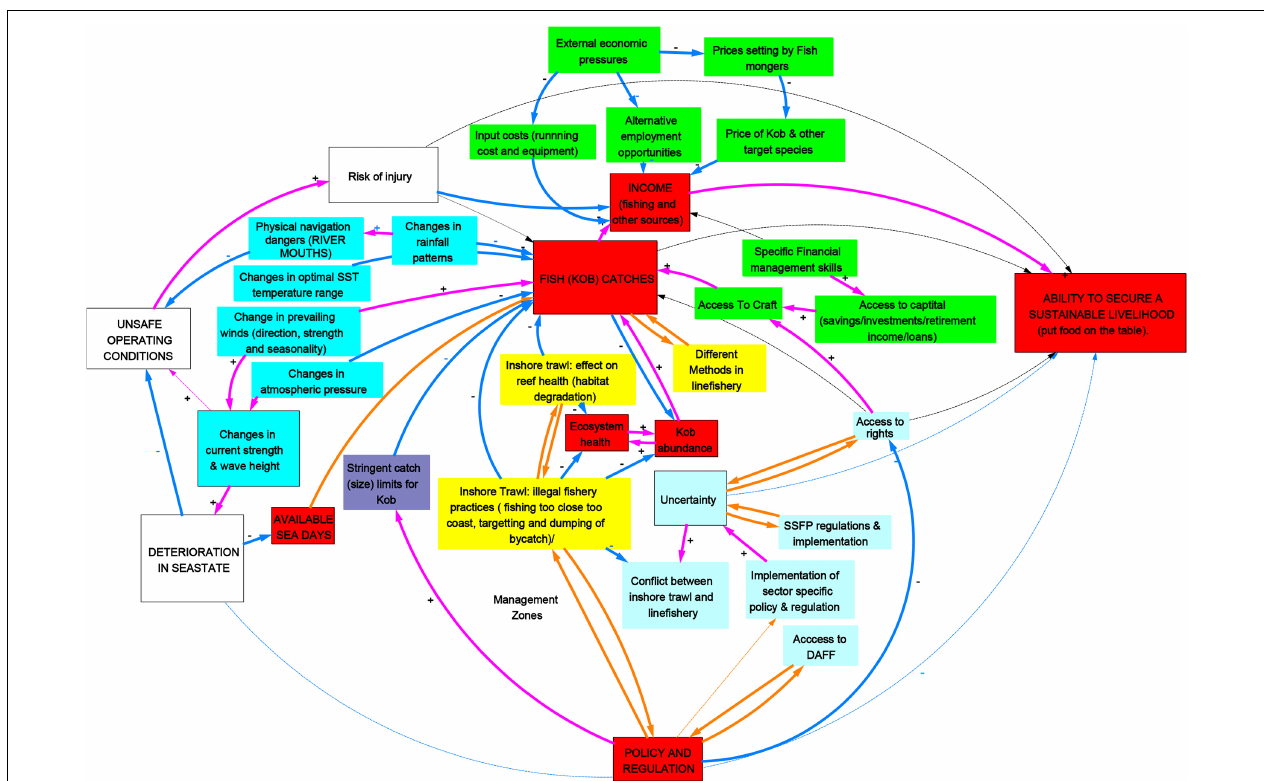
FIGURE 4 | Causal map showing direct and indirect drivers of change (stressors) in the southern Cape linefishery as compiled in collaboration with fishers. In this map the different colours represent different themes of drivers of change (stressors) – Red boxes: key stressors, Turquoise: Biophysical, Yellow: Biophysical (other fisheries), Light blue: Social networks, Green: Social and Economic; Purple: Regulation/management and White: seas state. Pink arrows are positive interactions, blue show negative interactions, orange arrows show interactions which are neither positive or negative. Dashed (broken) lines are indirect interactions – Black dash: Non- directional indirect interaction/stressor, Blue dash: Dampening (–) indirect interaction/stressor and Pink dash: Amplifying (+) indirect interaction/stressor (from Gammage and Jarre,